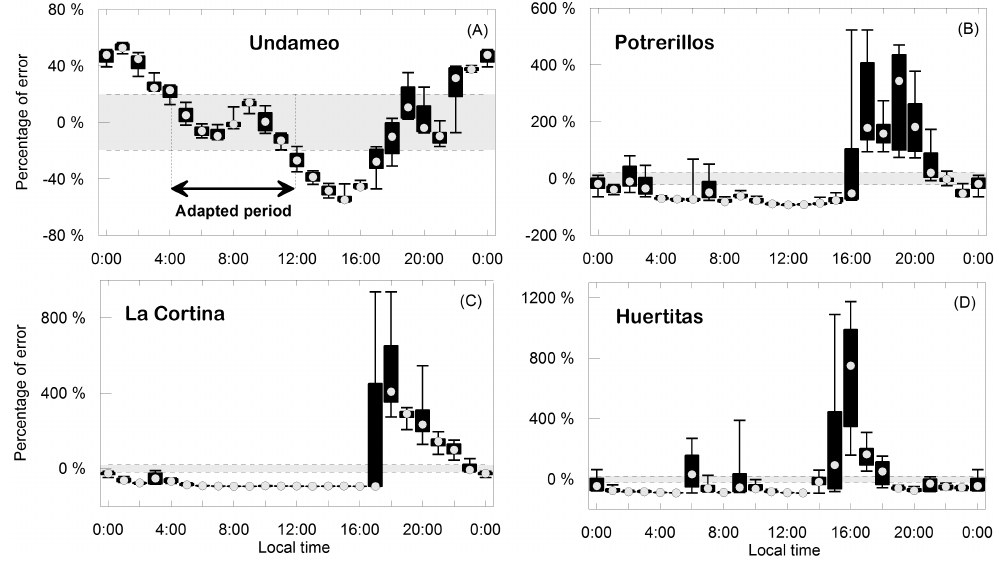
Fig. 6. Errors on SSY estimate related to S5 0 to S5 23 scenarios at each station. The 0% level represents SSY ref . Grey circles correspond to median values, boxes correspond to lower and upper quartiles and whiskers correspond to maximum and minimum errors.